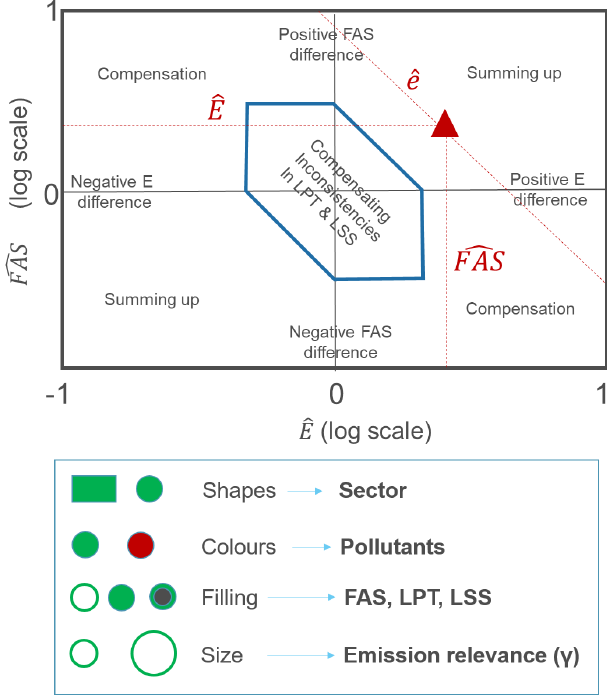
Figure 2. Diamond diagram and representation of the